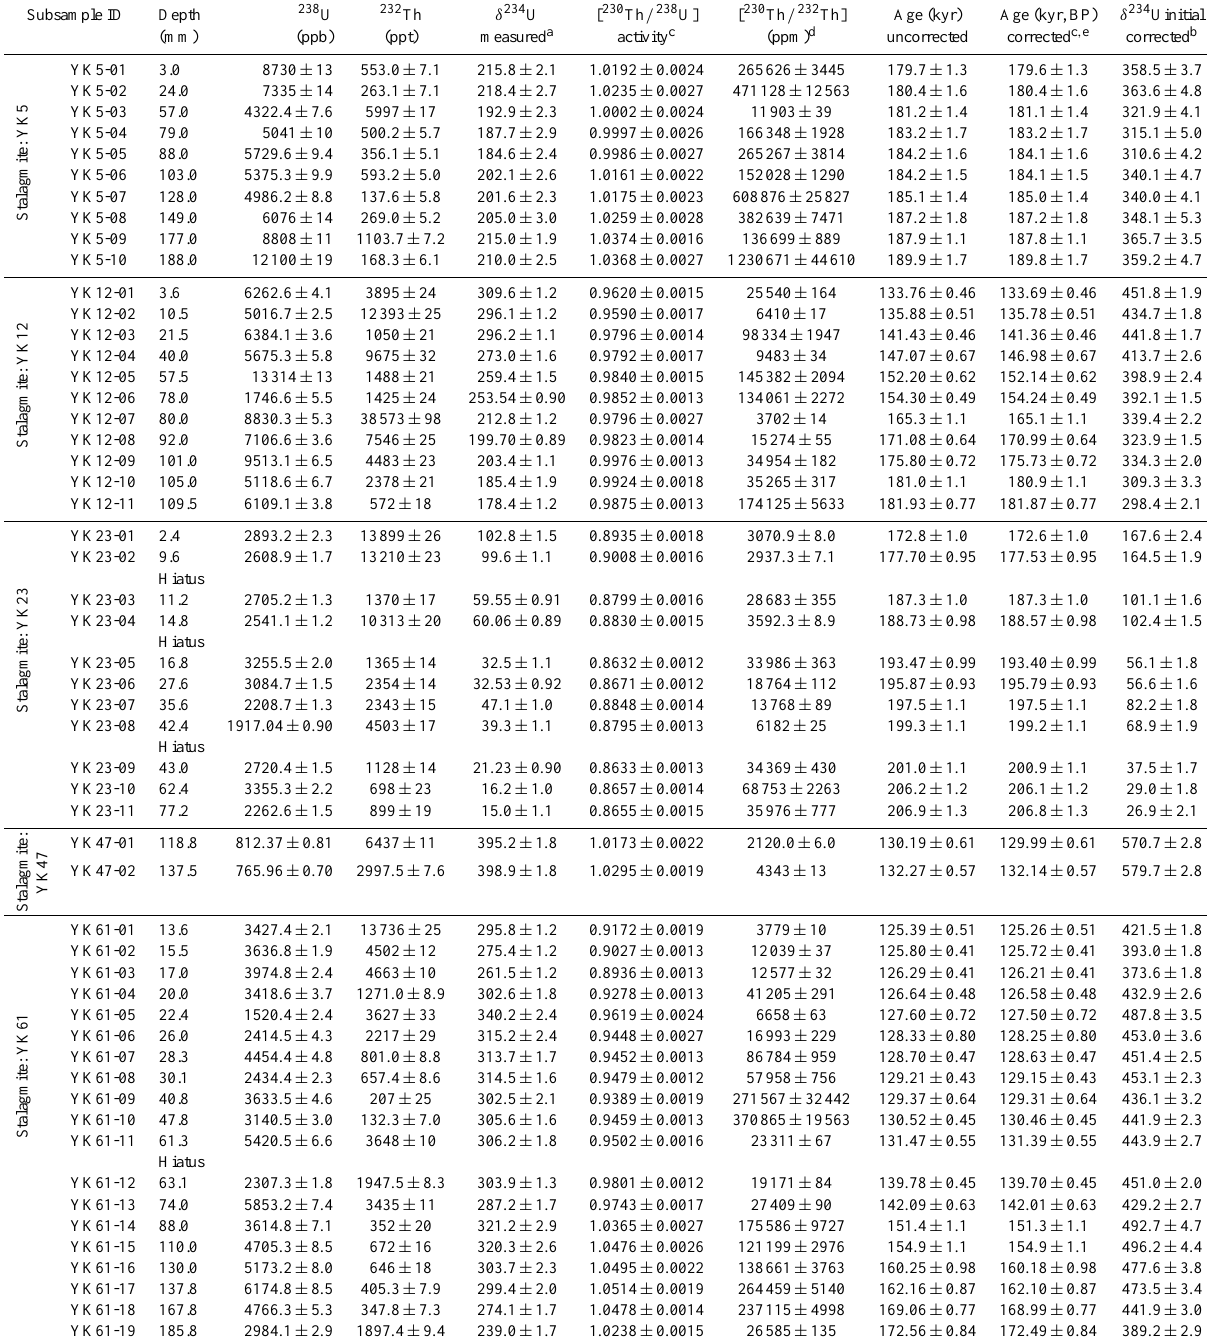
Table 1. U-Th isotopic compositions and 230 Th ages for subsamples of five Yangkou stalagmites on MC-ICP-MS at the HISPEC, NTU. Subsample